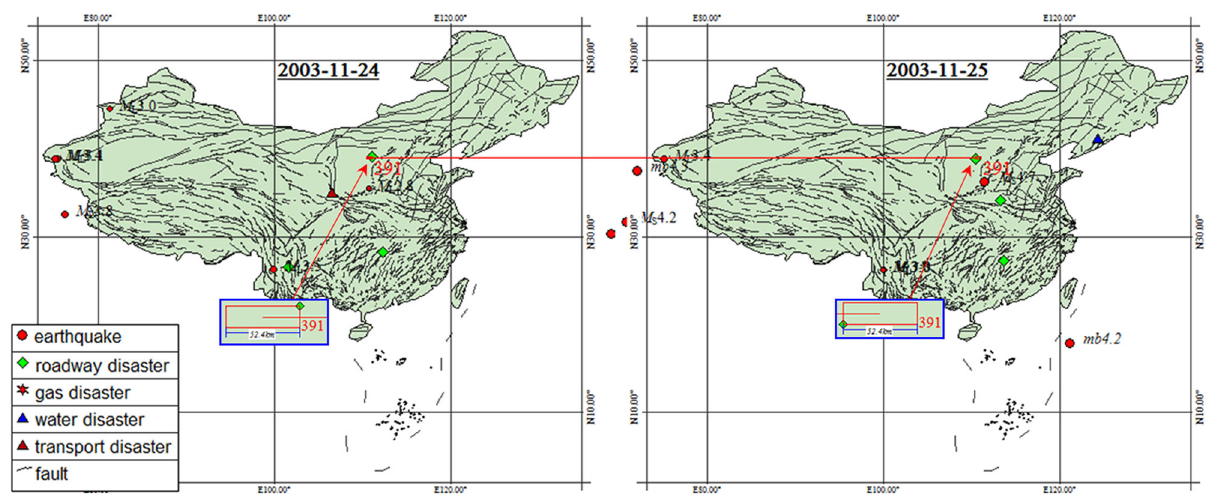
Fig. 2 Earthquakes and coal mine disasters occurring during the period from 24 to 25 November 2003